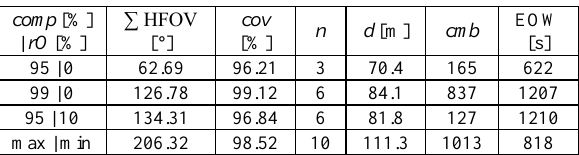
Table 5. Comparison of the computed